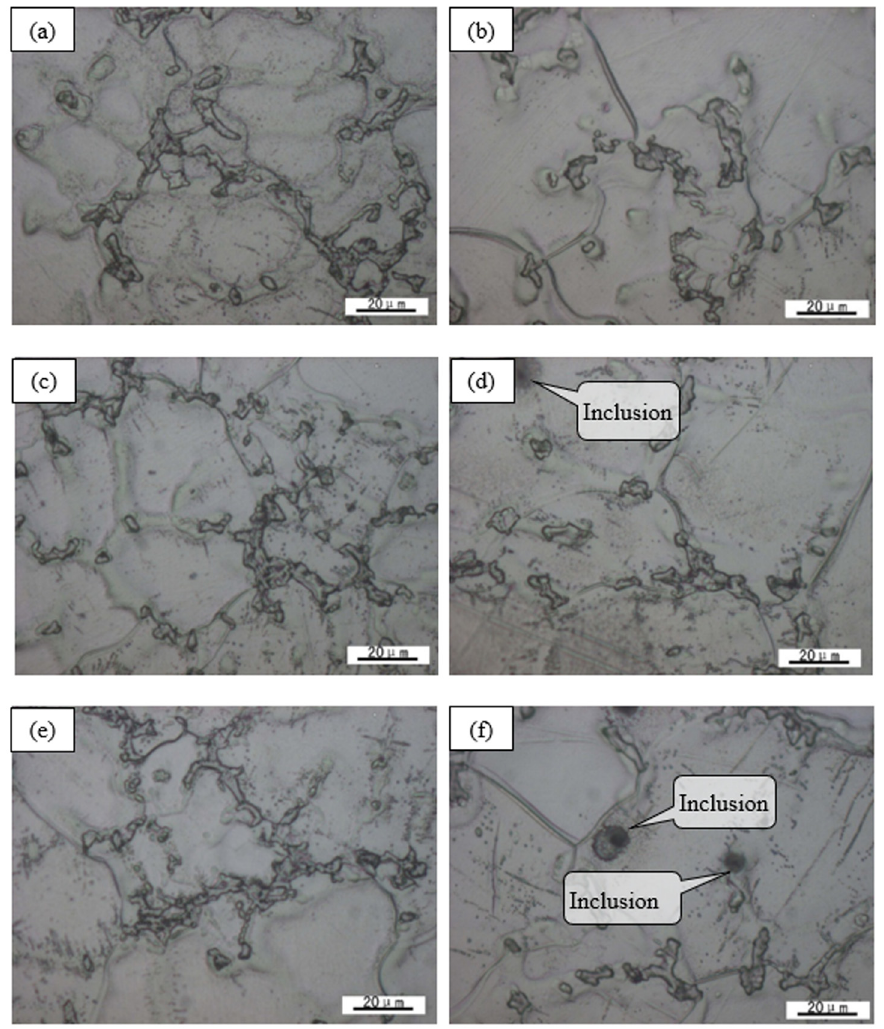
Figure 3. Optical microstructure of GWK alloys with different composition: ( a , b ) the center and edge of GWK-a ingot; ( c , d ) the center and edge of GWK-b ingot; ( e , f ) the center and outside of GWK-c ingot.